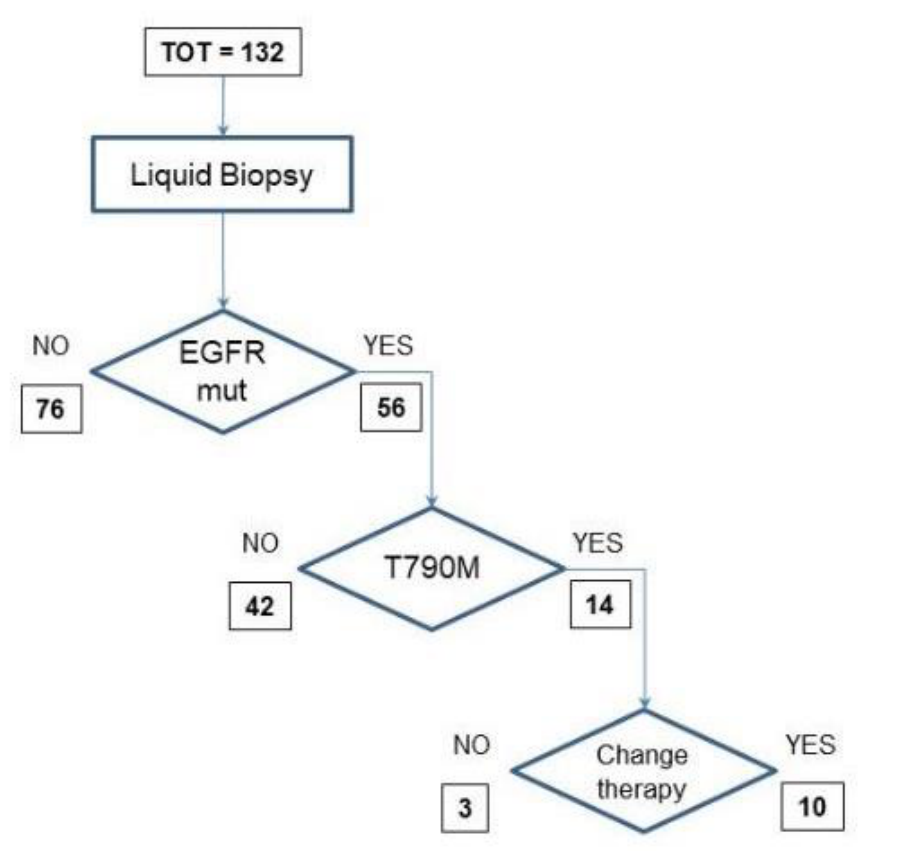
Figure 2. Flow-chart for EGFR mutation analysis for patients in progressive disease after TKI treat- ment.